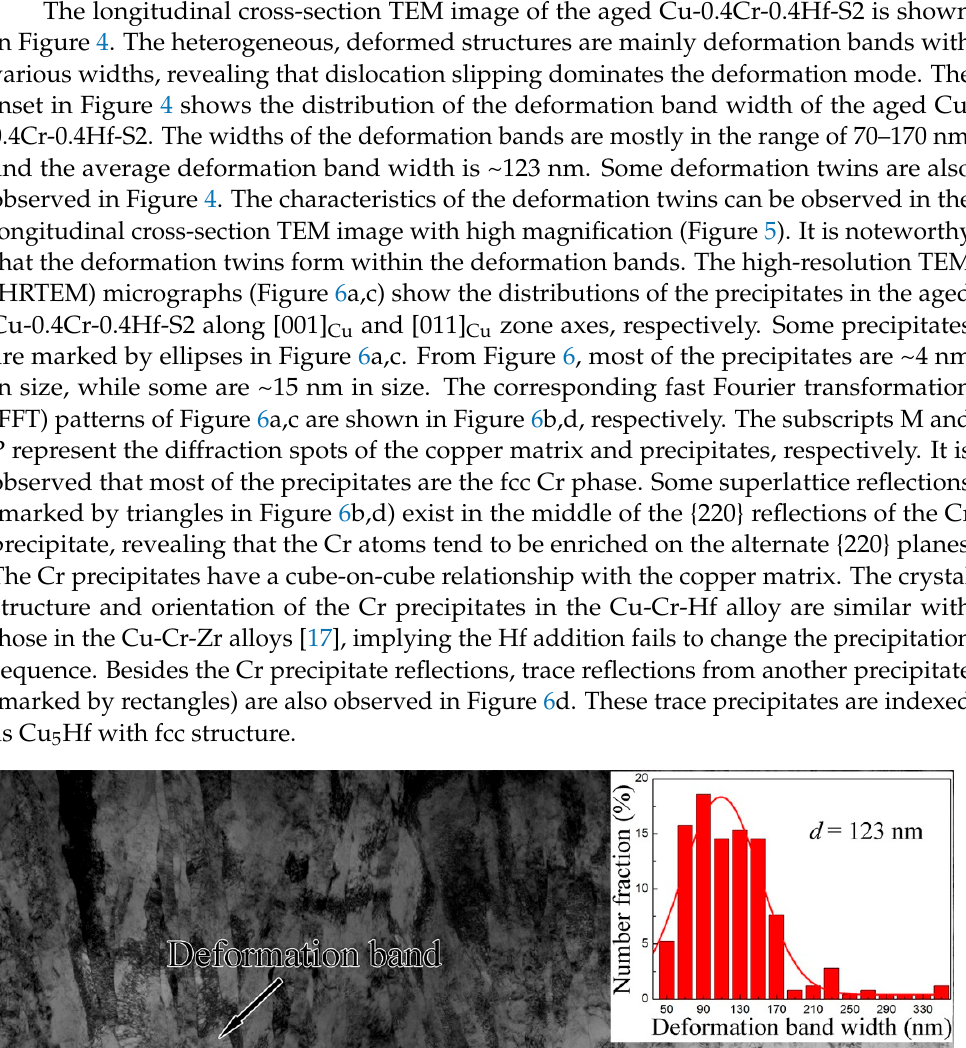
Figure 5. A high-magnification, longitudinal cross-section TEM observation of the aged Cu-0.4Cr- 0.4Hf-S2.